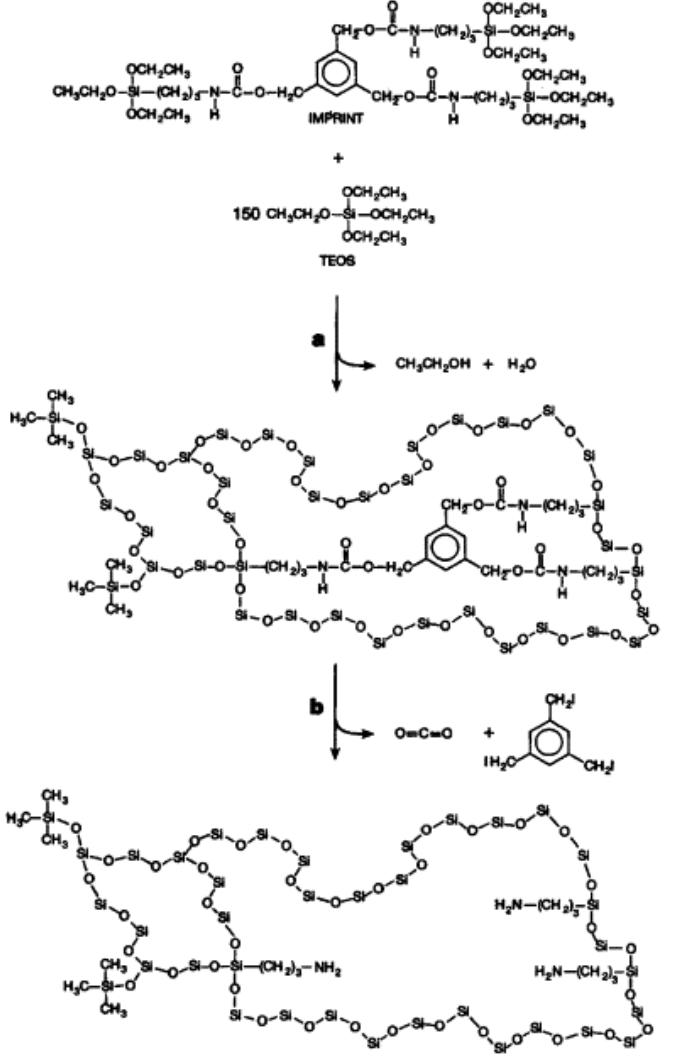
Figure 2. The formation of a covalent inorganic molecular imprint. ( a ) Sol – gel hydrolysis and condensation. ( b ) Removal of the covalently bound template. Reprinted from [22], © 2007 with permission from Elsevier.